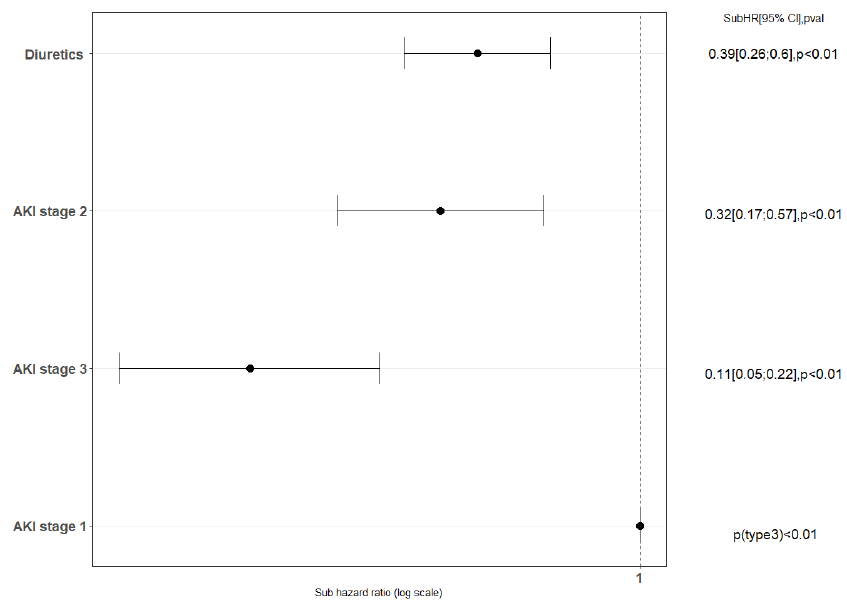
Figure 4. Factors associated with recovery from AKI, multivariate analyses, sub-distribution model. AKI: acute kidney injury; SubHR: sub hazard ratio. Variables with a p -value <0.1 in univariate analyses were age, lopinavir–ritonavir, diuretics, vasopressors and KDIGO stage. These covariates were considered into the final